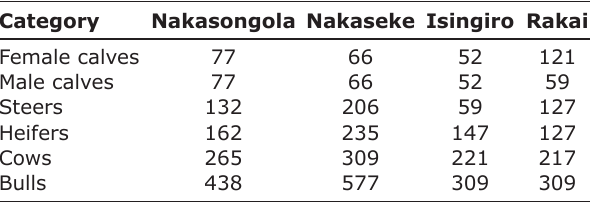
Table-4: Percentage age-specific off-take sale composition per district between January 2010 and January 2011 as revealed by sub-county livestock markets records. Category Rakai Isingiro Nakasongola Nakaseke Female calves